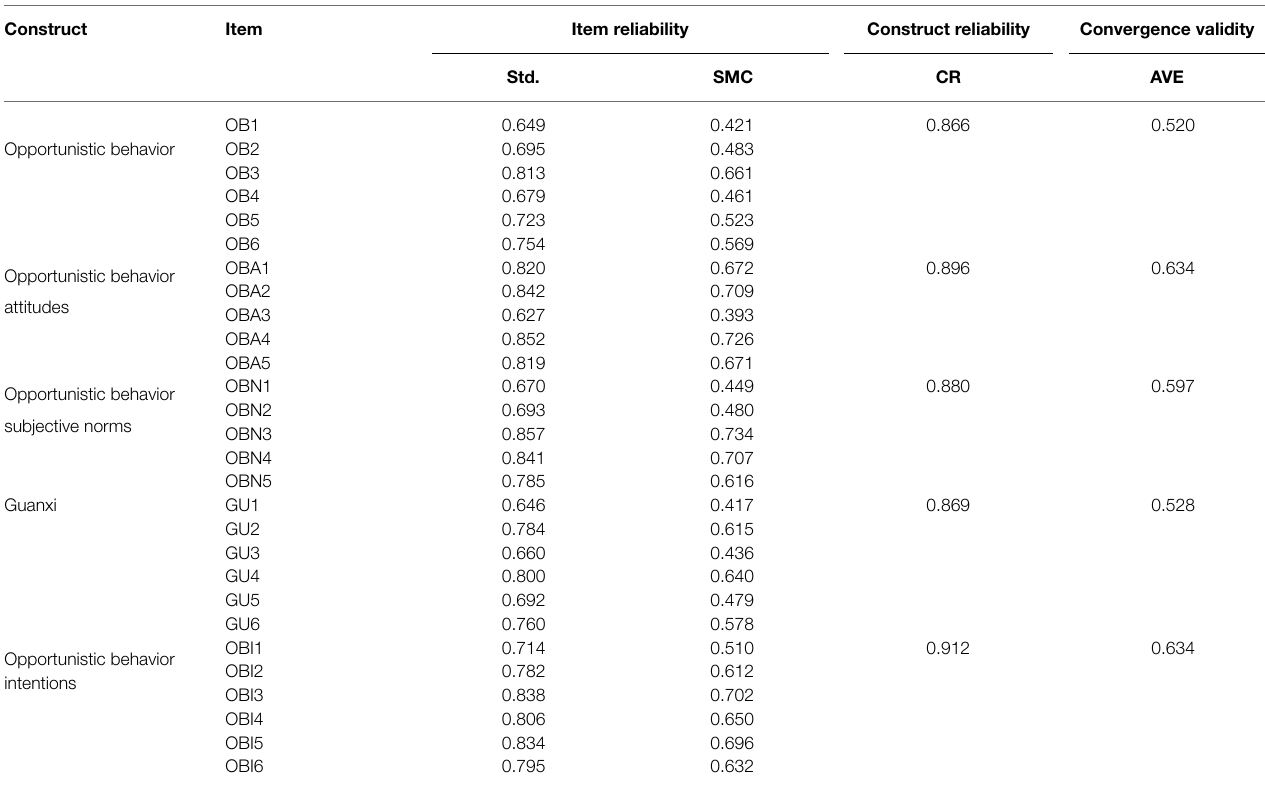
TABLE 4 | Item statistical analysis and convergent validity.